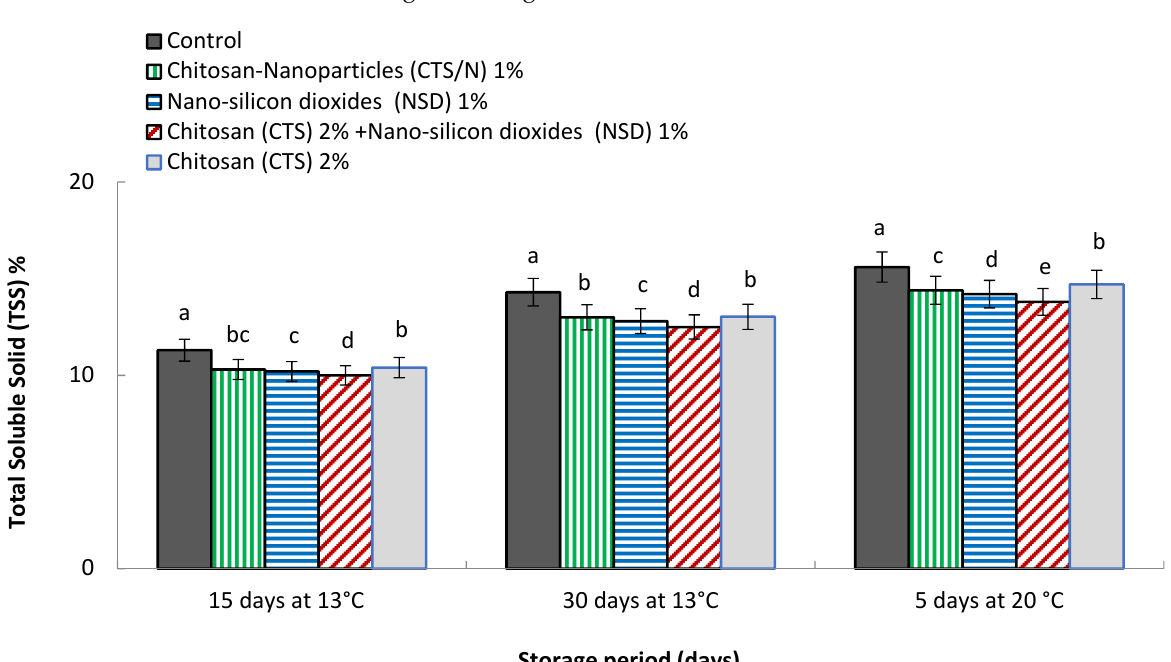
Figure 7. Total soluble solid (TSS) % as a mean of ‘Tommy Atkins’ mangoes from two seasons, stored at 13 ± 1 °C and 90–95% RH for 30 days. Afterward, the fruits were stored at 20 ± 2 °C and 70–75% RH for 5 days as the marketing period. Vertical bars indicate the standard error (SE) of the mean ( n = 5). The superscript letters followed by the same letters are not significantly different according to Duncan’s multiple range test at 0.05 level.